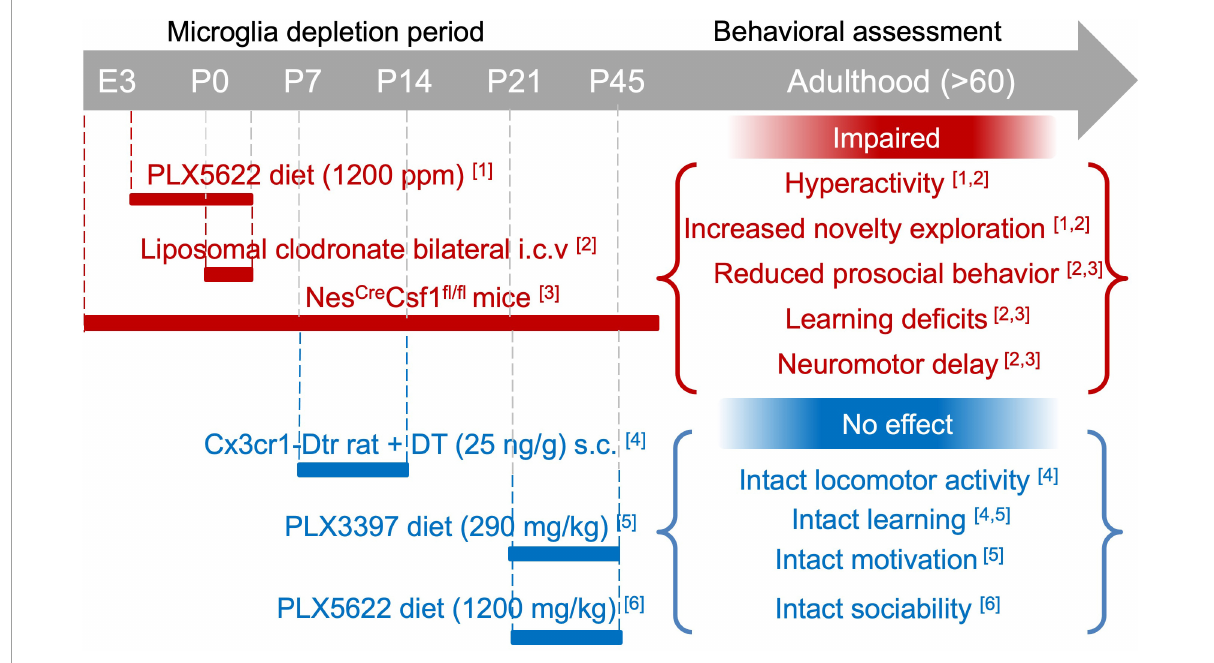
FIGURE4 Impact of microglia depletion during development on adult behaviour. Graphic overview of studies that depleted microglia during specific developmental stages (from embryogenesis to adolescence) and assessed the behavioural performance later in time (during adolescence or adulthood). Briefly, microglia depletion during the embryonic and early postnatal periods causes longlasting behavioural and cognitive deficits ( red ), while transient postnatal microglia depletion had no subsequent impact on adult behaviour ( blue ). [1] Rosin et al., 2018; [2] Vanryzin et al., 2016; [3] Kana et al., 2019; [4] Soch et al., 2020; [5] Smith et al., 2020; [6] Ikezu et al., 2021. See section 4.2 for detailed